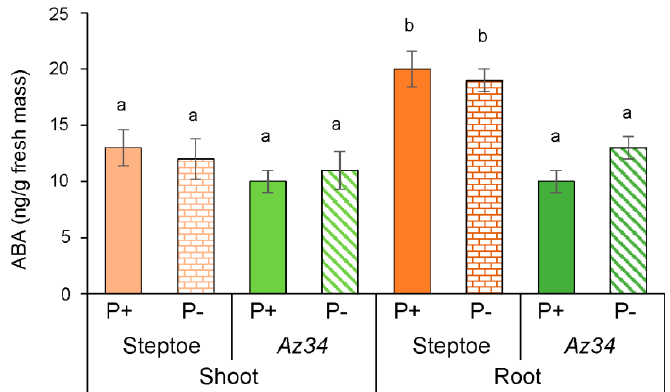
Figure 4. ABA concentration (calculated per g fresh mass) in shoots and roots of 4-days-old barley plants (cv. Steptoe and Az34 ) grown for 1 day on nutrient solutions with (P+) or without (P − ) phosphate. Bars are means ± S.E. of n = 9, with significant ( p ≤ 0.05) differences between all genotype/treatment combinations marked with different letters (ANOVA, LSD).